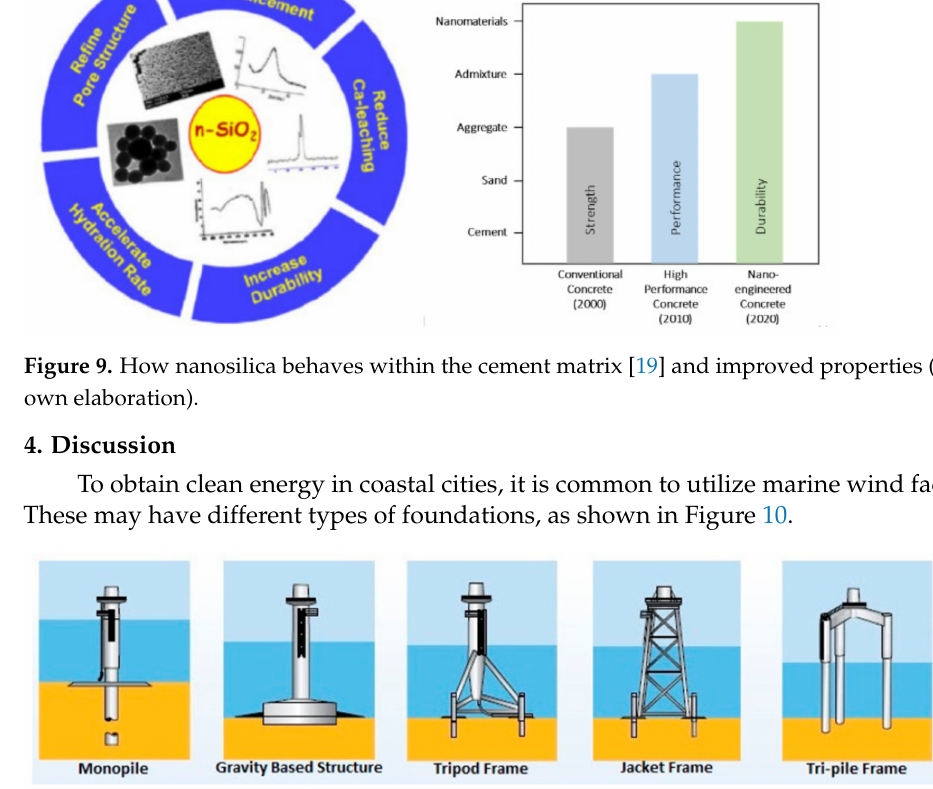
Figure 10. Main types of direct foundations in offshore wind energies